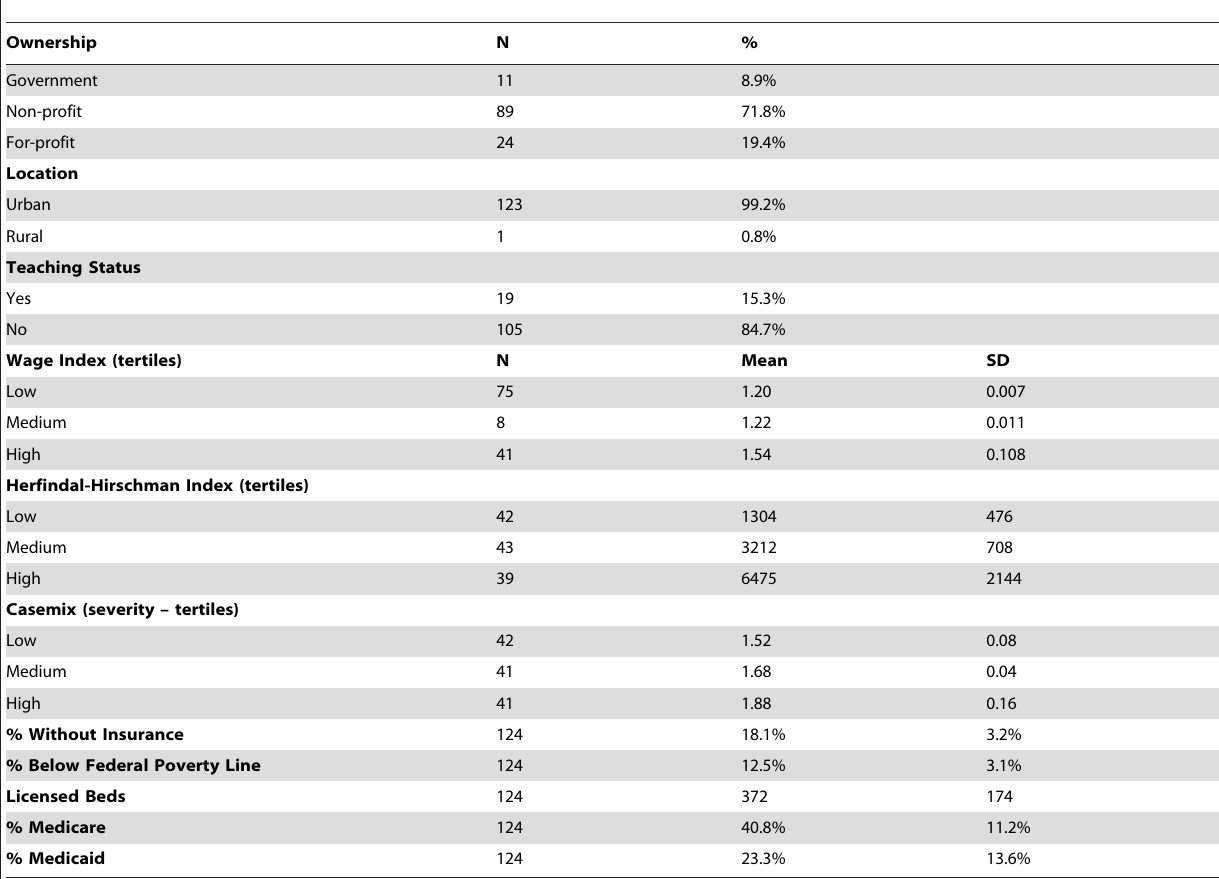
Table 2. Characteristics of California hospitals in sample (n=